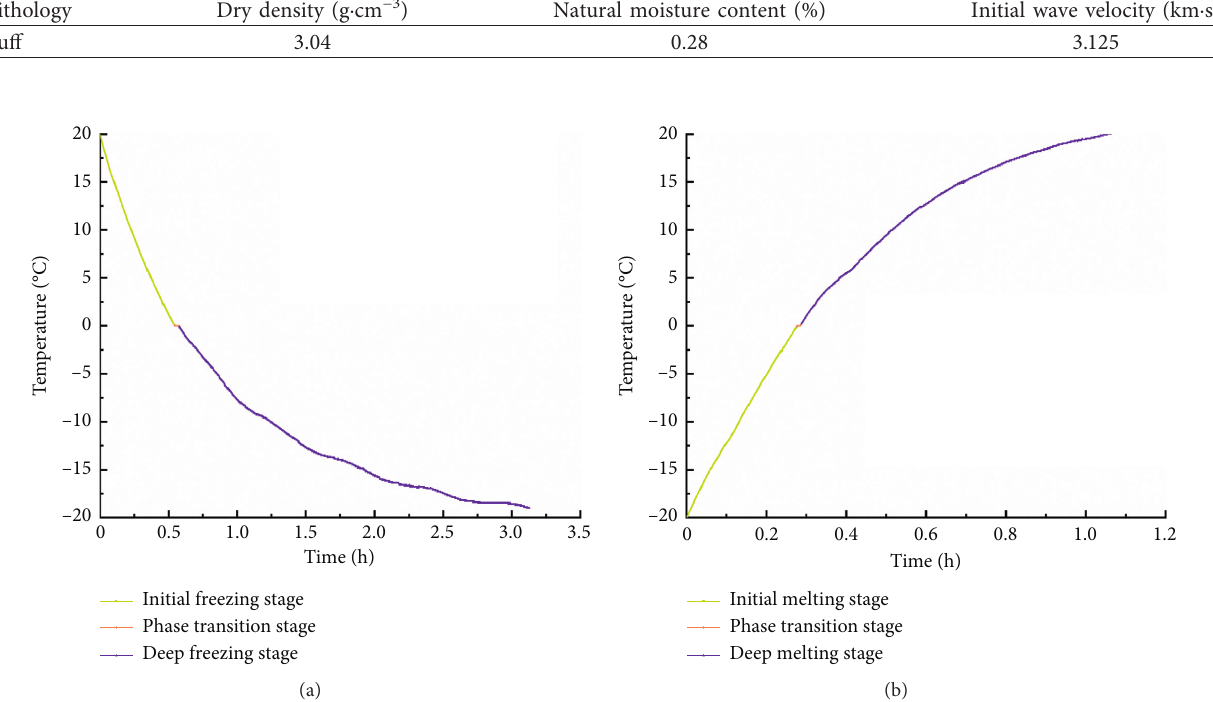
Figure 2: Time diagram of the rock sample reaching the specified temperature for the fifth freeze-thaw cycle. (a) Freezing process; (b) melting